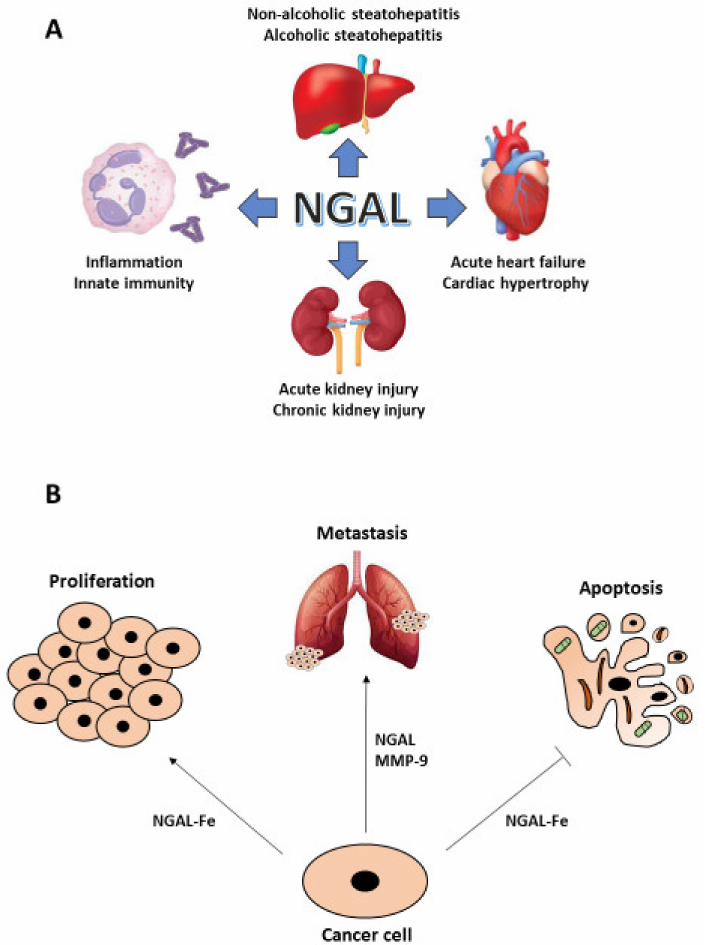
Figure 1. NGAL in human diseases. Different pathologic conditions show a crucial involvement of NGAL: from the inflammatory response to the acute and chronic kidney injury as well to the cardiac and liver diseases ( A ). In particular, NGAL plays an important role in cancer given its ability to induce cell growth and to protect neoplastic cells from apoptosis, when complexed with iron (Fe), and to promote metastasis, when complexed with MMP-9 ( B